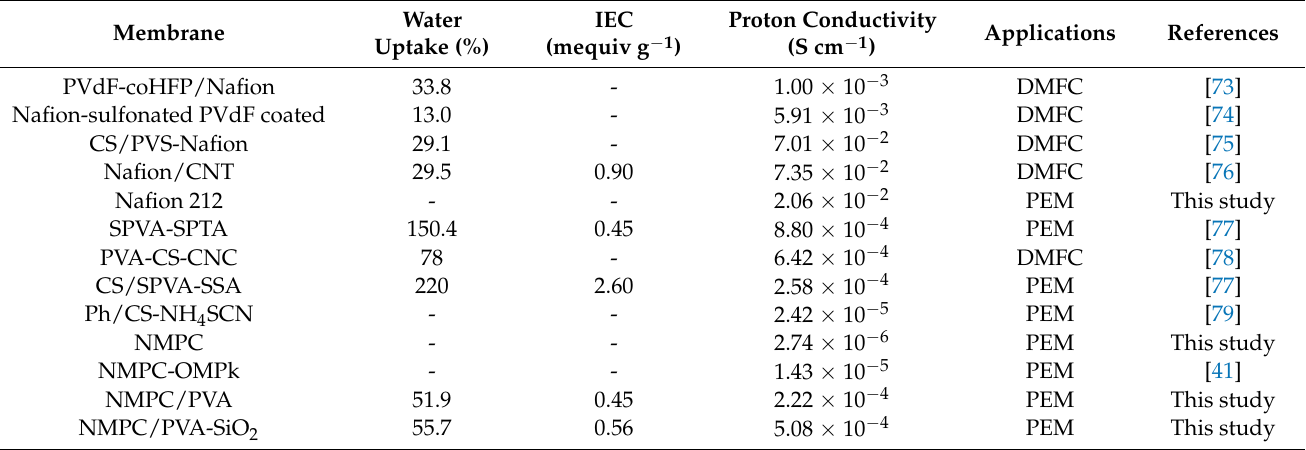
Table 3. Comparisons of water uptake, IEC, and proton conductivity for Nafion-based membranes, PVA-based membranes, and chitosan-based